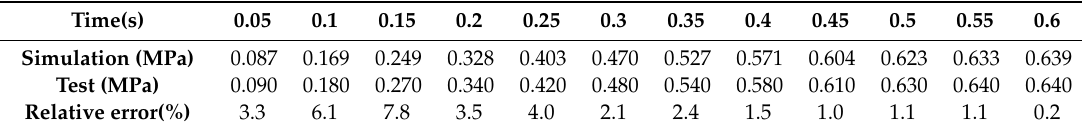
Table 2. Comparison of the simulation and test of rapid charging process.